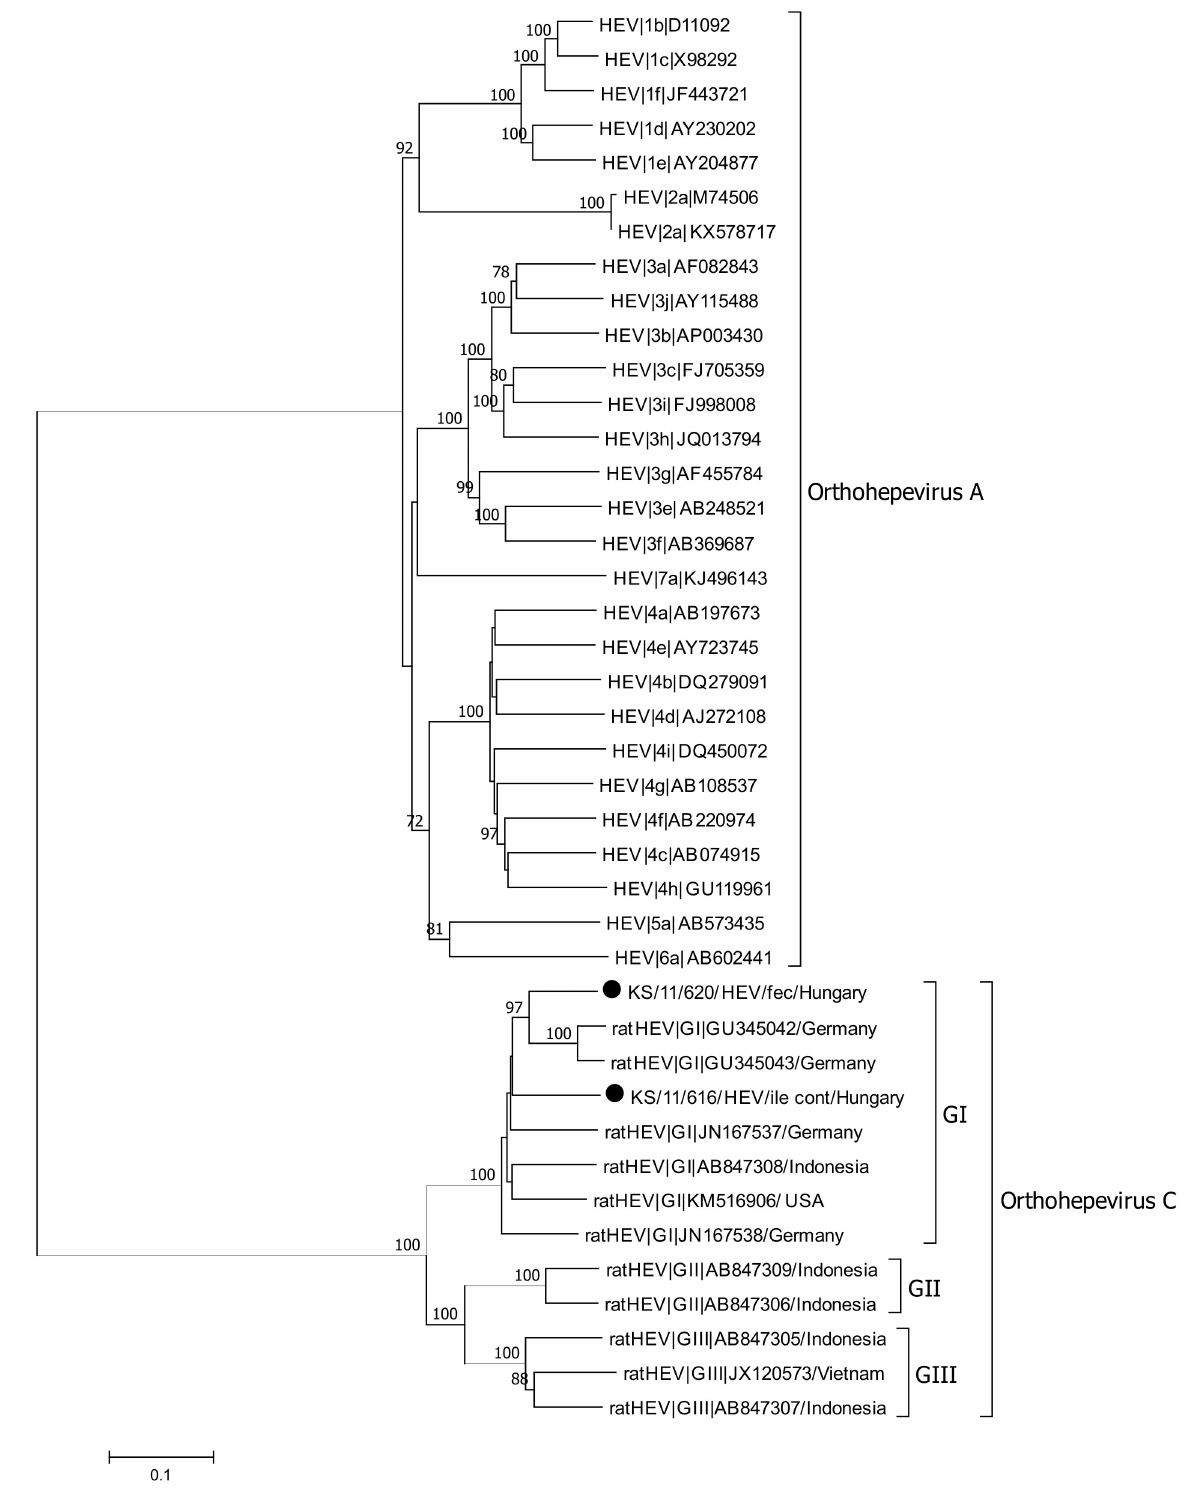
Figure 5. Phylogenetic analysis of the entire genome from ratHEV strains detected in this study (marked with dot) and reference sequences of representative strains of species Orthohepevirus C and Orthohepevirus A . The phylogenetic tree was reconstructed using the Neighbor-Joining method with Bootstrap test (1000 replicates) and the Tamura–Nei parameter method available in MEGA7. The bar indicates the number of substitutions per site. Bootstraps values above 70 are shown. Abbreviations: cont = content; fec = feces; ile =